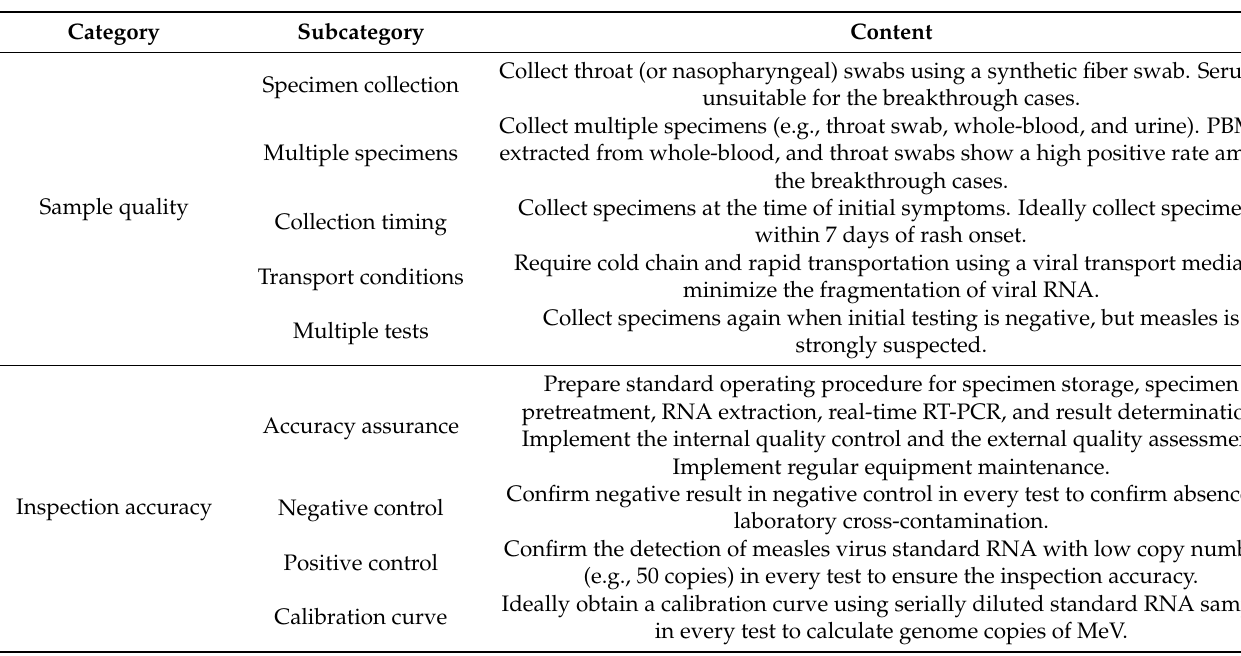
Table 1. Requirements for accurate real-time RT-PCR without false-negative results